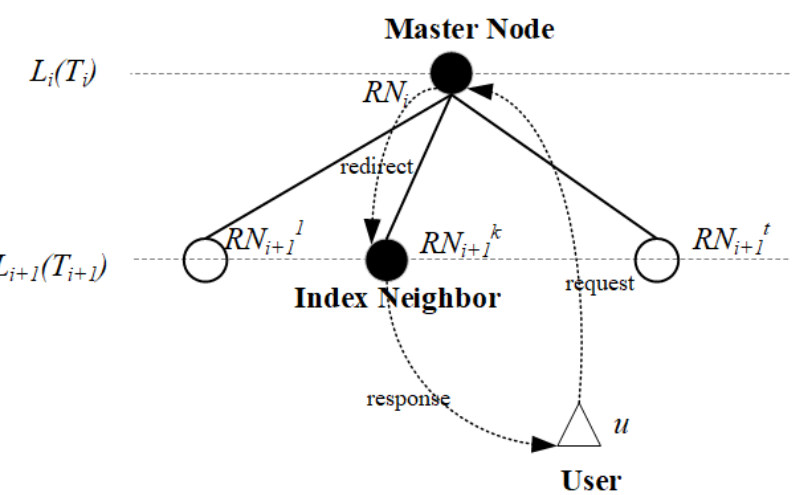
Figure 2. An index neighbor structure example, which shows the relationships among master node, index neighbor node, and users of the master node. In the service scenario involving index neighbor, a resolution request is sent from a user of the master node to the master node, and then redirected to the index neighbor. The resolution response is then sent by the index neighbor to the